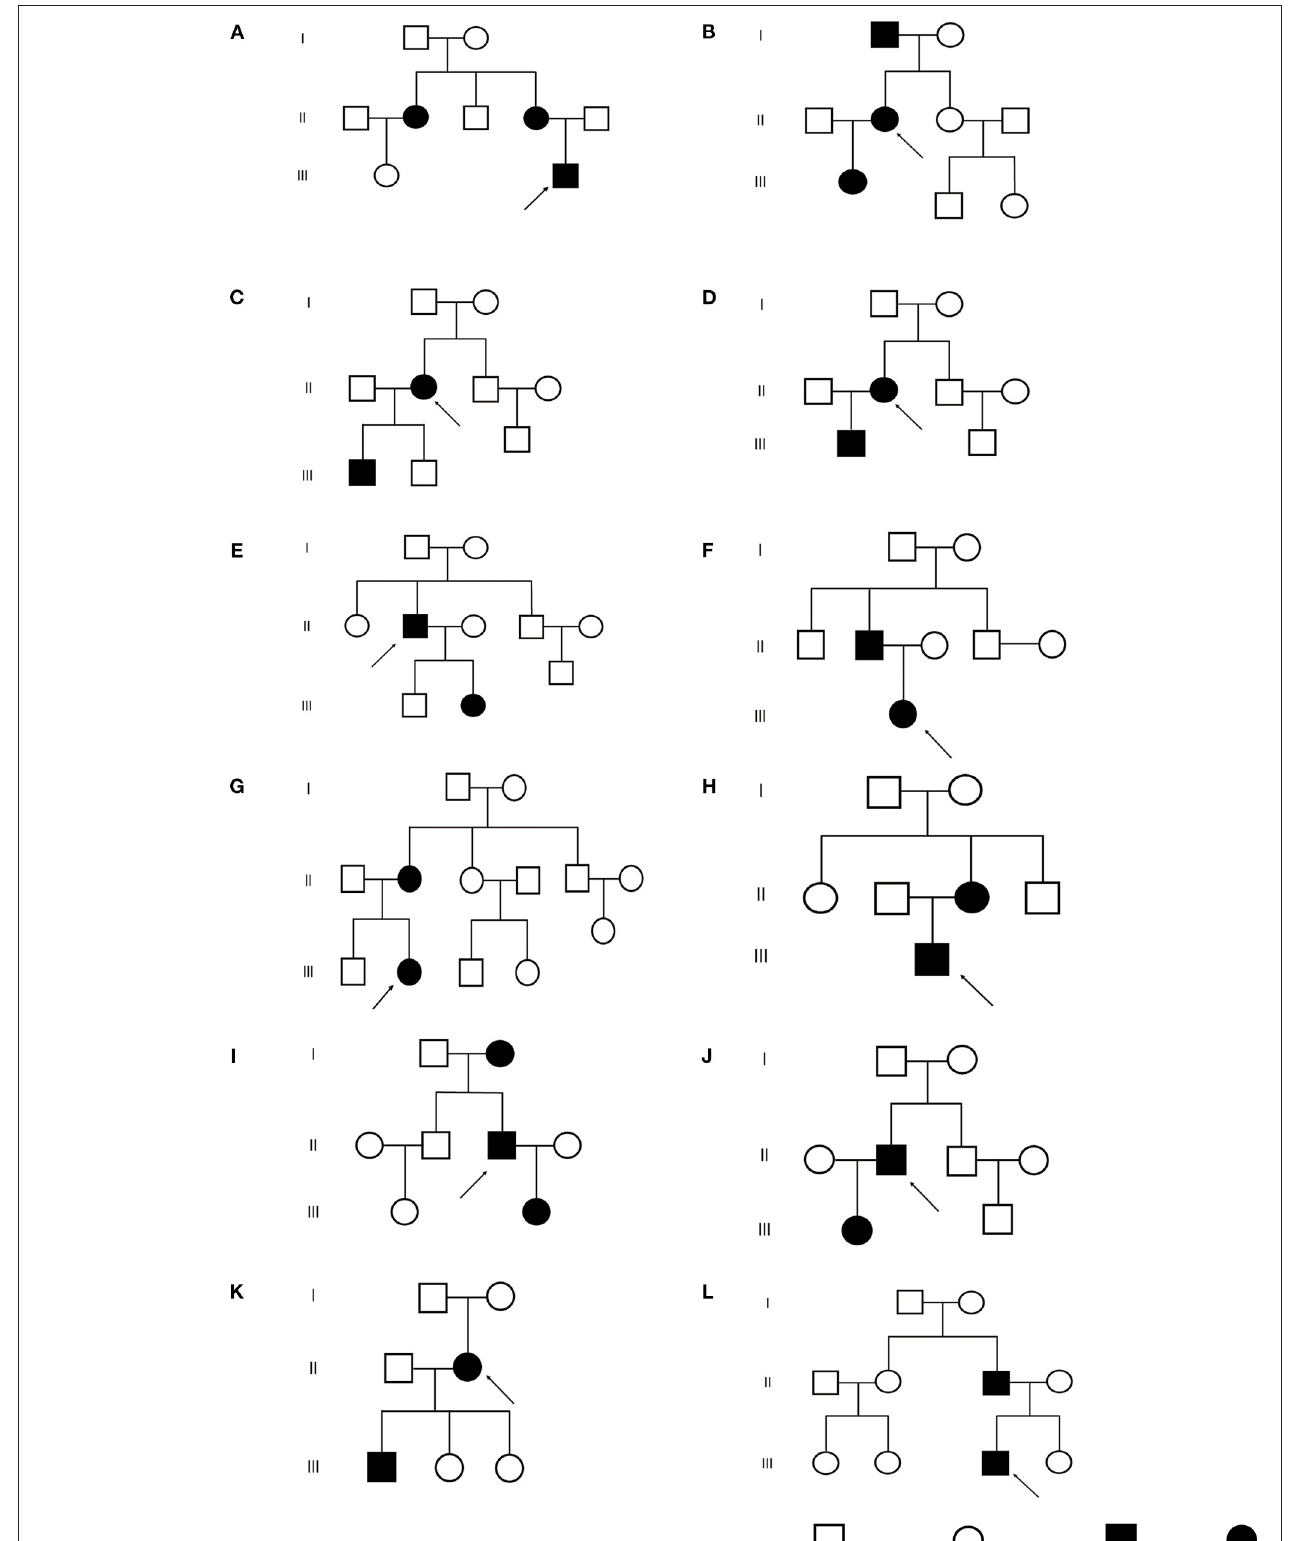
FIGURE 2 | Pedigrees of the 12 TSC families. (A–L) Represent (A–L) family respectively. : proband : normal male : normal female : TSC male : TSC